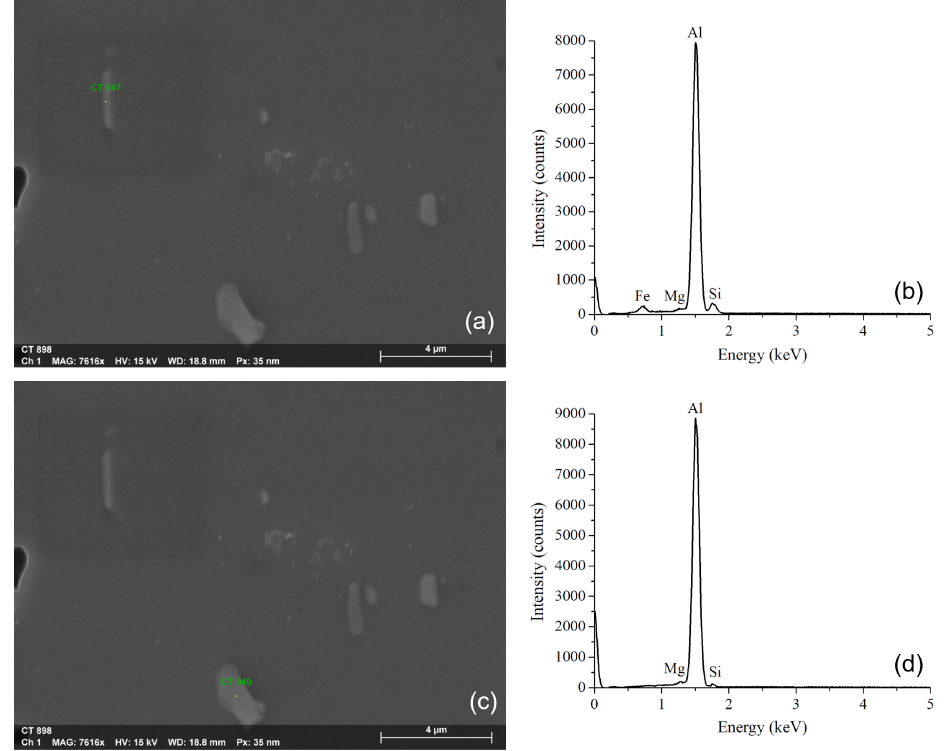
Figure 3. Rod-shaped metallic inclusions ( a ) containing Al, Mg, Fe, and Si, determined by EDS ( b ). The plate-shaped inclusions ( c ) exhibit Al, Mg, and Si in the EDS spectrum ( d